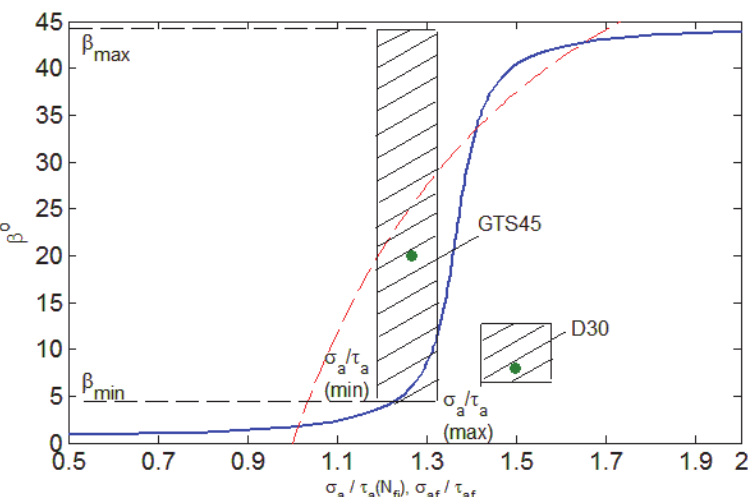
Figure 6: Exemplary analysis of selected materials.